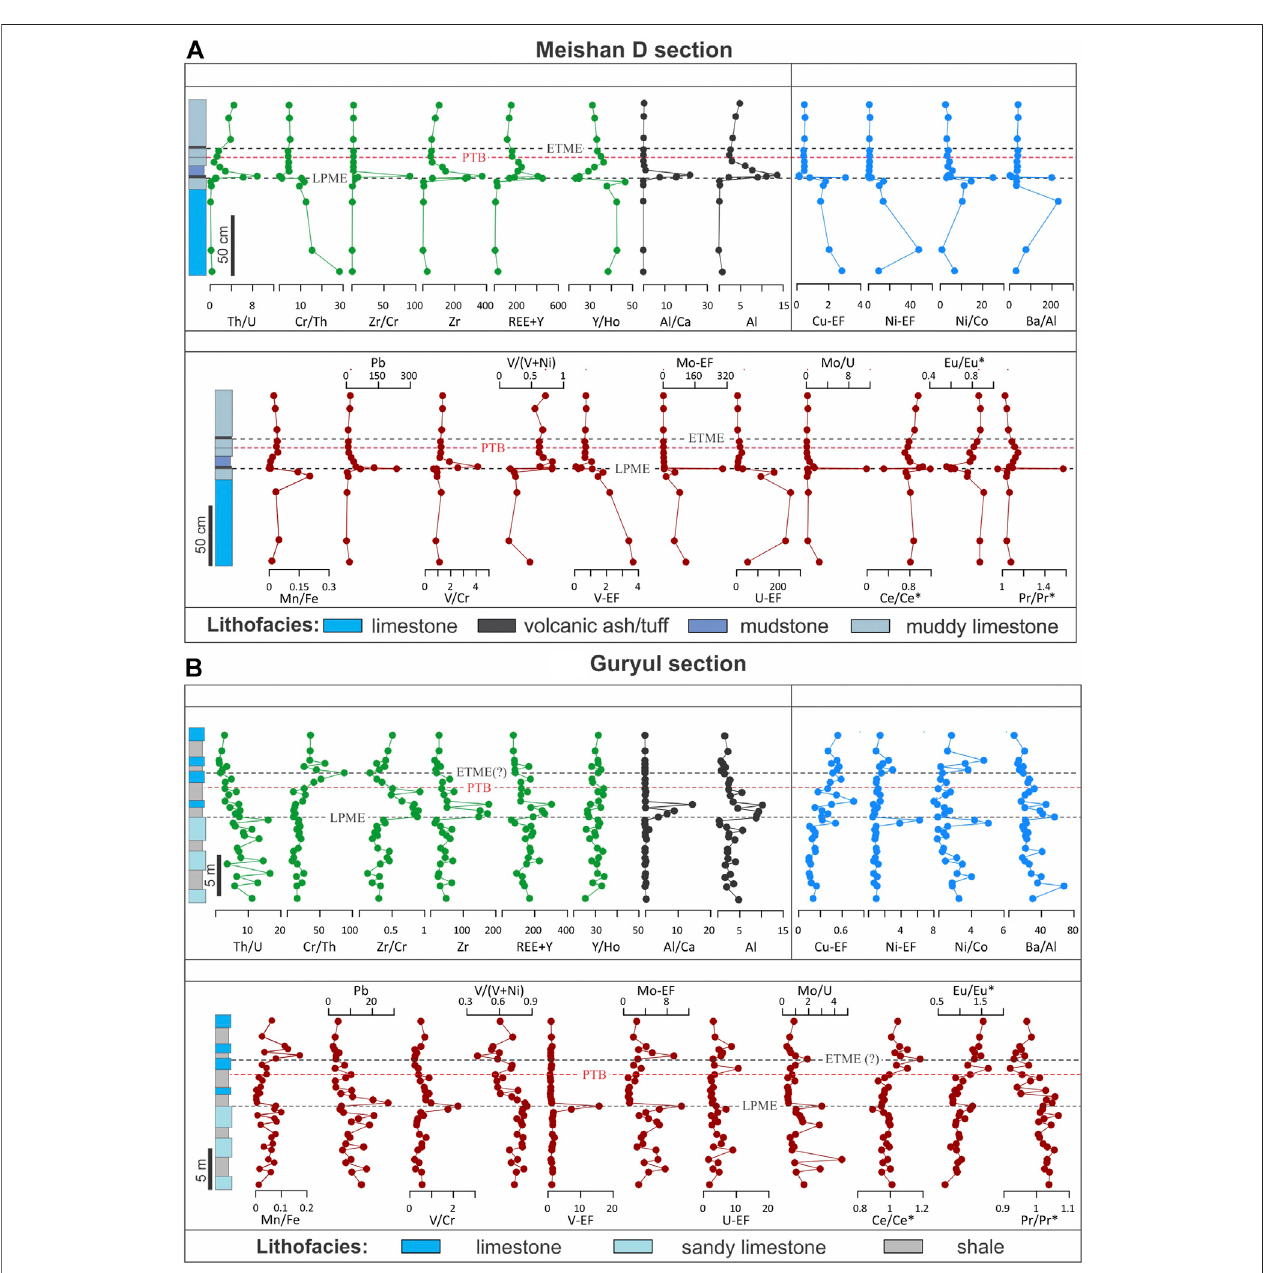
FIGURE 2 | Trace-element and elemental-ratio chemostratigraphy encompassing: Th/U, Cr/Th, Zr/Cr (Zr) in ppm, Ʃ REE + Y, Y/Ho, Al/Ca and (Al) in wt%, Cu-EF, Ni-EF, Ni/Co, Ba/Al, Mn/Fe (Pb) in ppm, V/Cr, V/(V + Ni), V-EF, Mo-EF, U-EF, Mo/U, Ce/Ce*, Eu/Eu* and Pr/Pr* for the (A) Meishan D (GSSP) and (B) Guryul Ravine